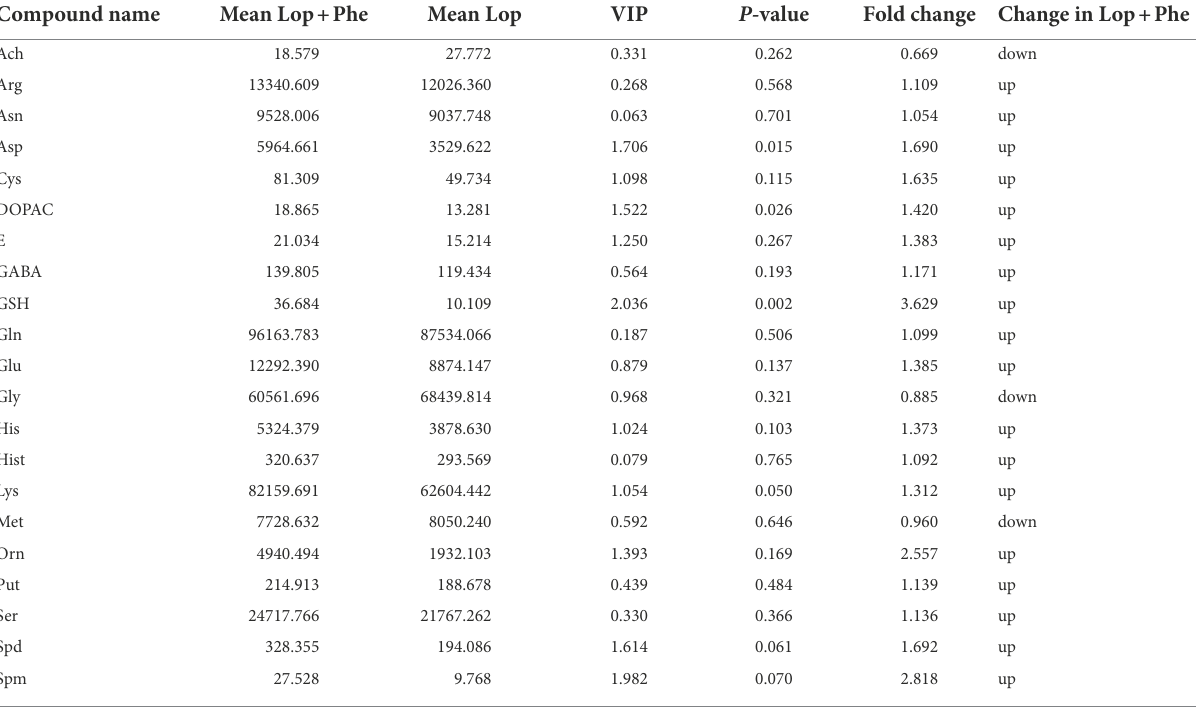
TABLE 2 Differential abundance of metabolites between the Lop and Lop + Phe